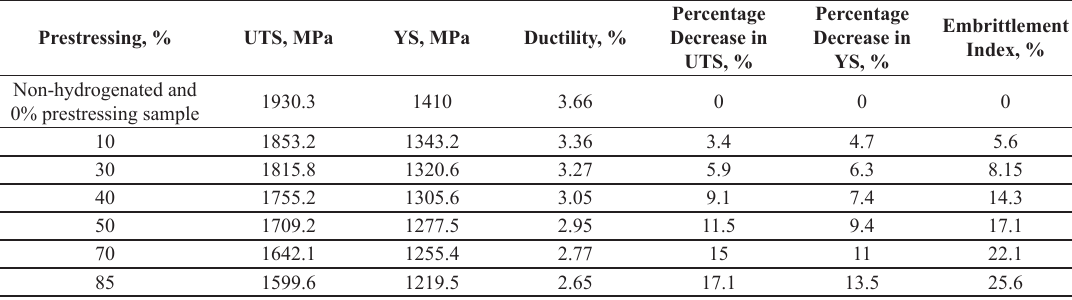
Table 2. Tensile characteristics of the plasma-hydrogenated prestressing steel wire samples. Prestressing, %